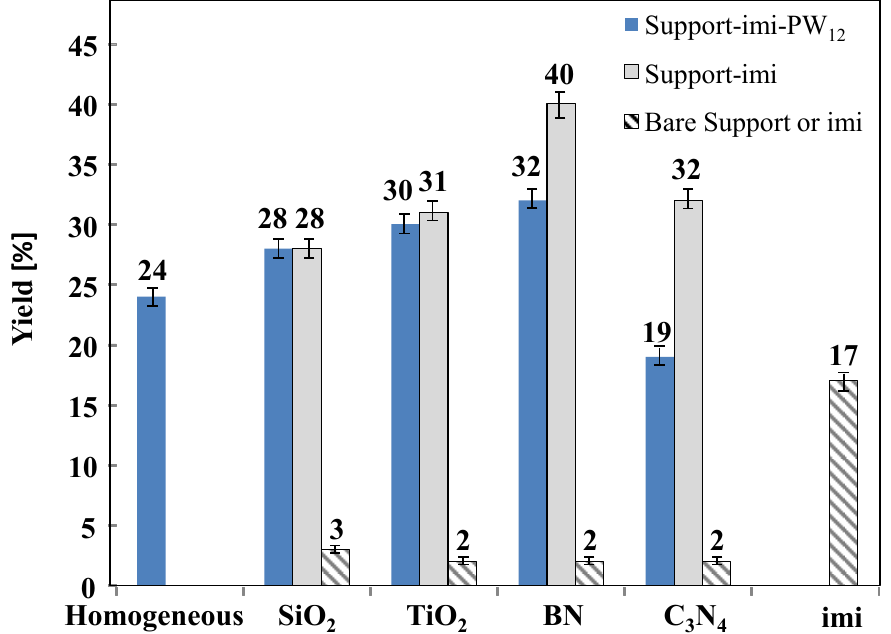
Figure 7. Yield of HMF for catalytic reactions carried out in aqueous medium at 165 °C for 3 h in the presence of the different catalysts. Initial substrate concentration 0.3 M at natural pH.